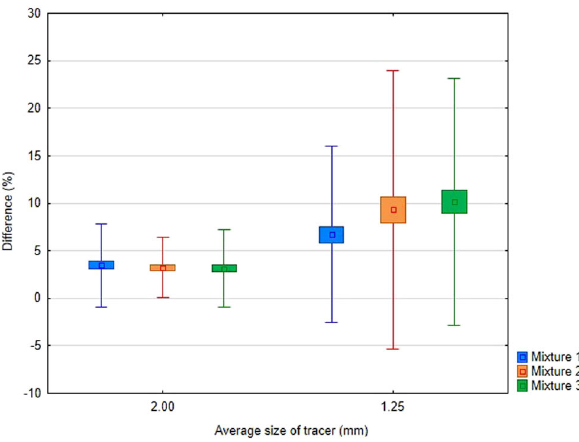
Figure 4: A box plot graph of the di ff erence between the results obtained by the two methods for the average size of the tracer d 1 = 2.00 and d 2 = 1.25 mm ( point: mean, box: mean ± standard error, whiskers: mean ± 2 × standard deviation ) .